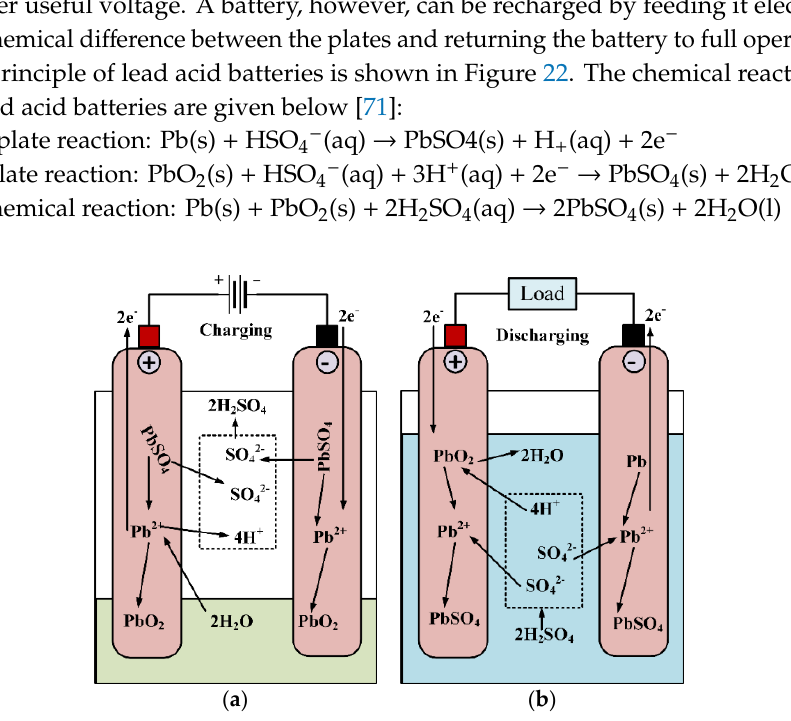
Figure 22. Working principle of rechargeable lead acid battery during ( a ) charging and ( b ) discharging